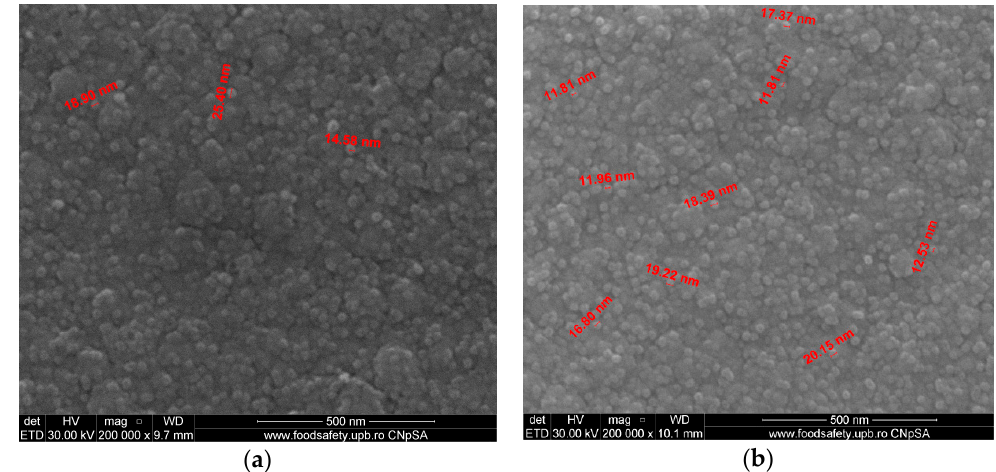
Figure 4. FE-SEM analyses of Co-Cr alloy samples fabricated by DMLS and coated with composite thin film of Ta 2 O 5 (75%) and ZnO (25%) by e-gun: ( a ) sample S3 without post-treatment, ( b ) sample S4 with post-treatment (×200,000).